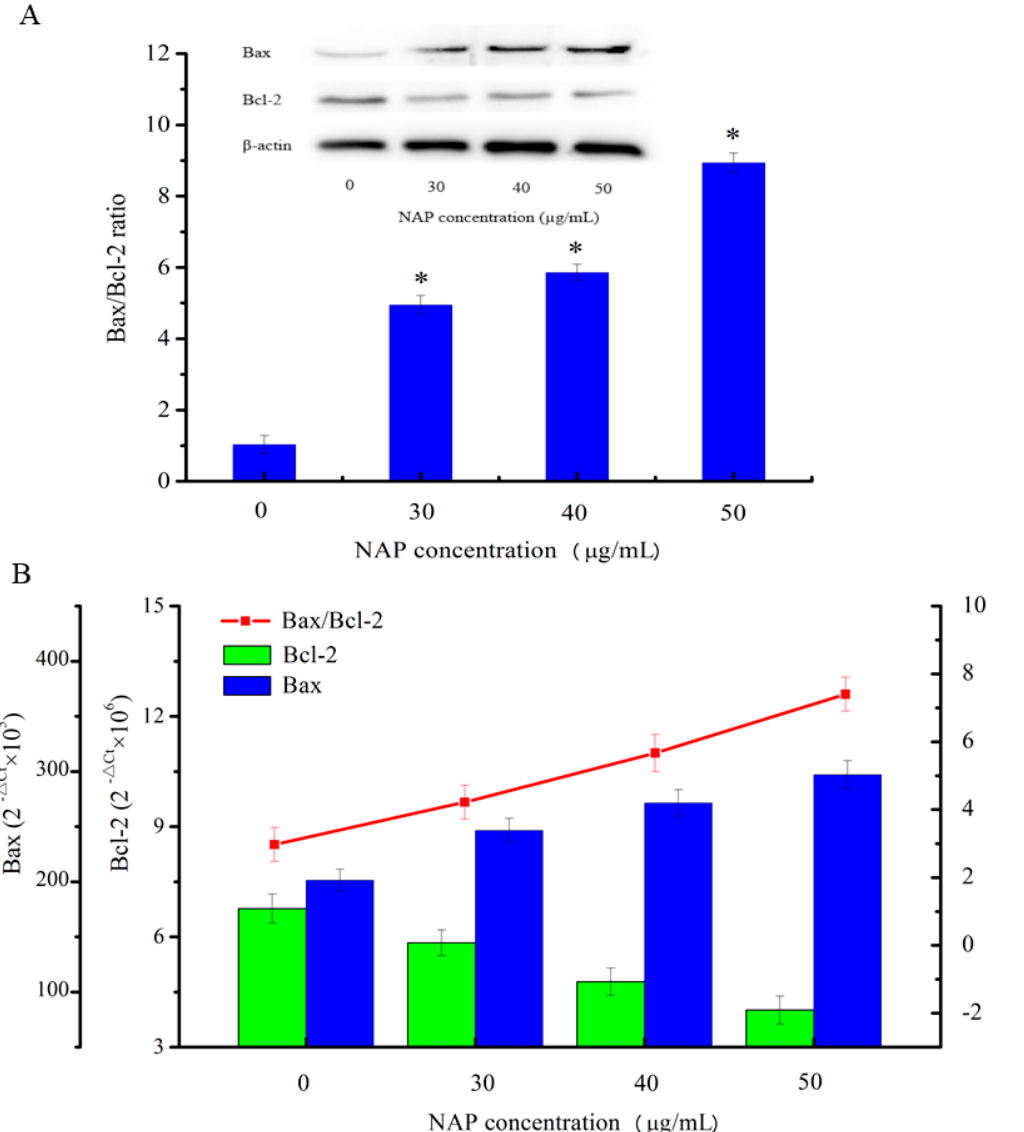
Figure 6. Expression of the apoptosis-associated proteins Bax and Bcl-2 in H1299 cells treated with NAP for 24 h. ( A ) Western blotting of Bax and Bcl2 expressed in H1299 cells treated with 0, 30, 40, and 50 µ g/mL NAP and the Bax/Bcl2 ratio. The blots were detected with β -actin antibody to determine equal sample loading. * p < 0.05 vs. control; ( B ) The mRNA expression level of Bax and Bcl2 in H1299 cells treated with 0, 30, 40 and 50 µ g/mL NAP and the Bax/Bcl2 ratio.